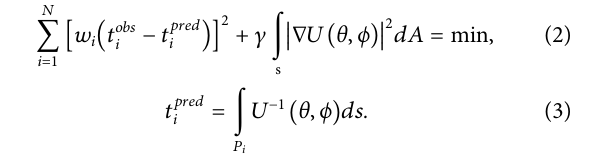
Frontiers in Earth Science |